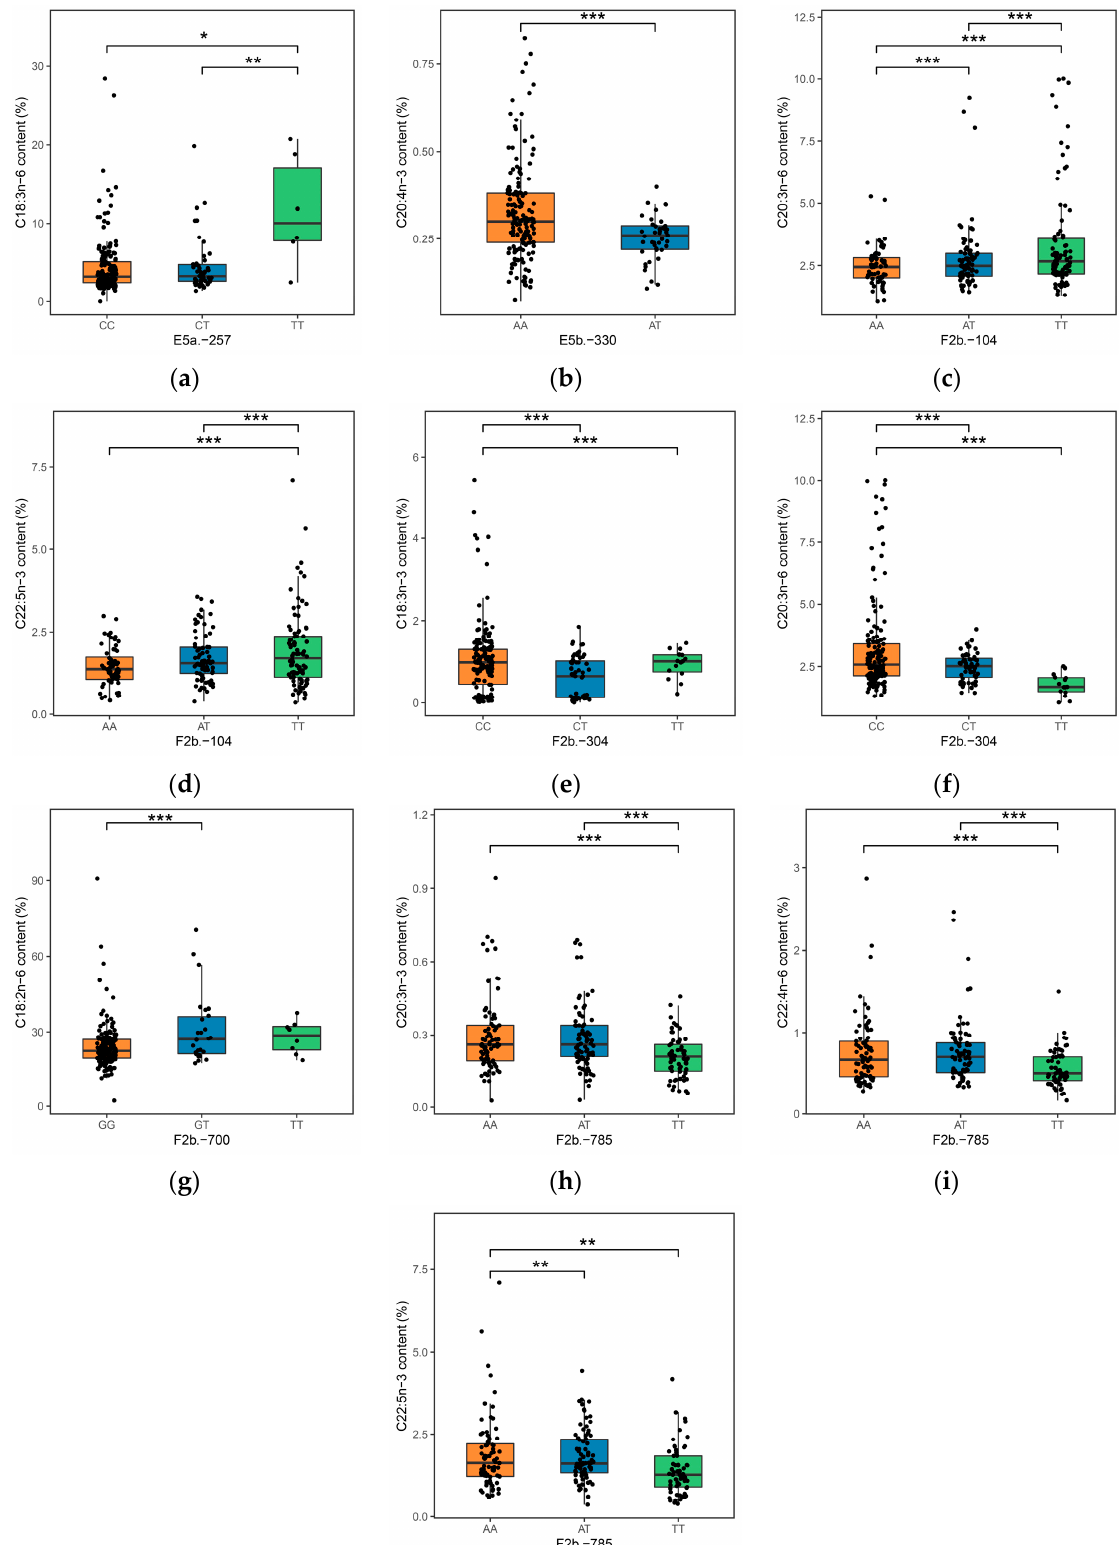
Figure 1. Box plots showing di ff erent PUFA content di ff erences among distinct genotypes. ( a ): E5a.- 257; ( b ): E5b.-330; ( c , d ) F2b.-104; ( e , f ) F2b.-304; ( g ) F2b.-700; ( h – j ) F2b.-785. * represented FDR p val- ues < 0.05. ** meant FDR p values < 0.01. *** indicated FDR p values <